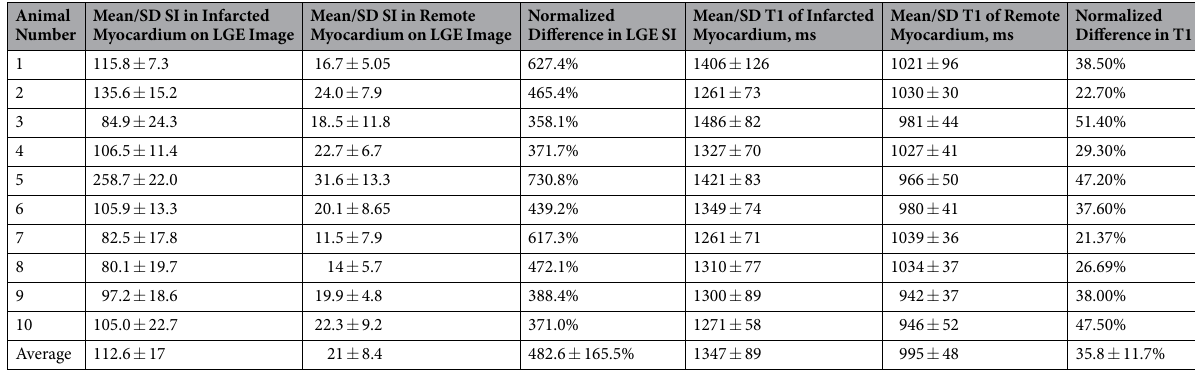
Table 1. Detailed T1 value and SI of LGE in remote and infarct area (averaged to each animal). SI = signal intensity, SD = Standard Deviation. Normalized Difference in LGE SI/T1 = (Infarcted SI/T1 − Remote SI/T1 )/ Remote SI/T1